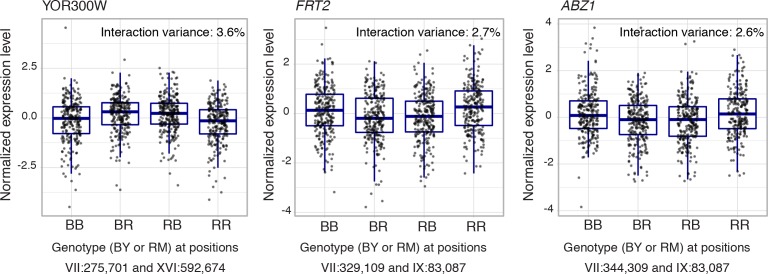
Epistatic interactions without additive effects.Shown are expression levels of three genes without any additive signal at either of the two interacting markers.